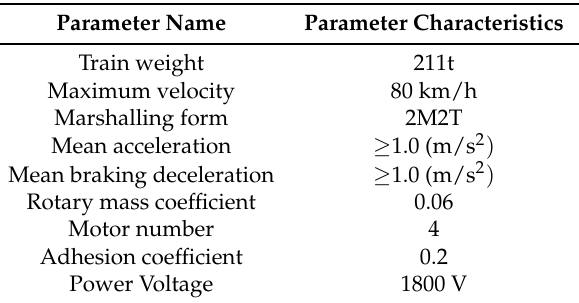
Table 2. Characteristics of the